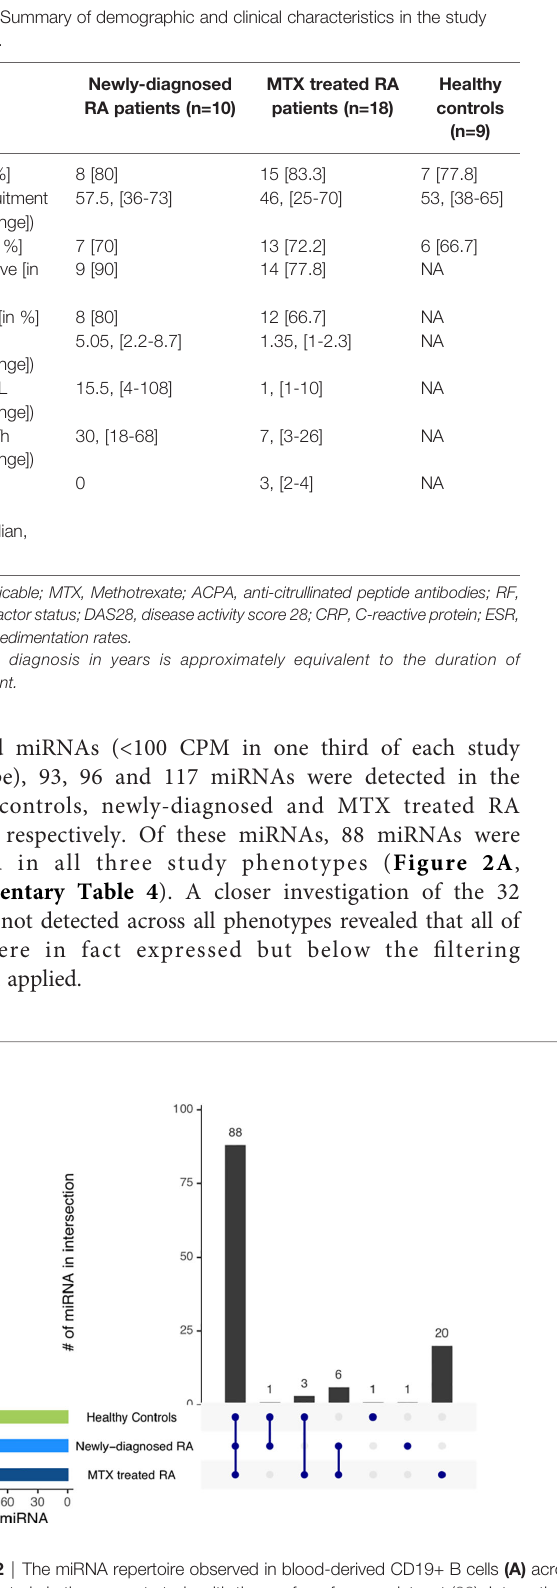
FIGURE 2 | The miRNA repertoire observed in blood-derived CD19+ B cells (A) across the different study phenotypes and (B) comparing the miRNA repertoire of healthy controls in the present study with those of a reference dataset (29). Interactions are indicated by the blue dots and lines. The number of miRNAs in the intersection is represented by the black